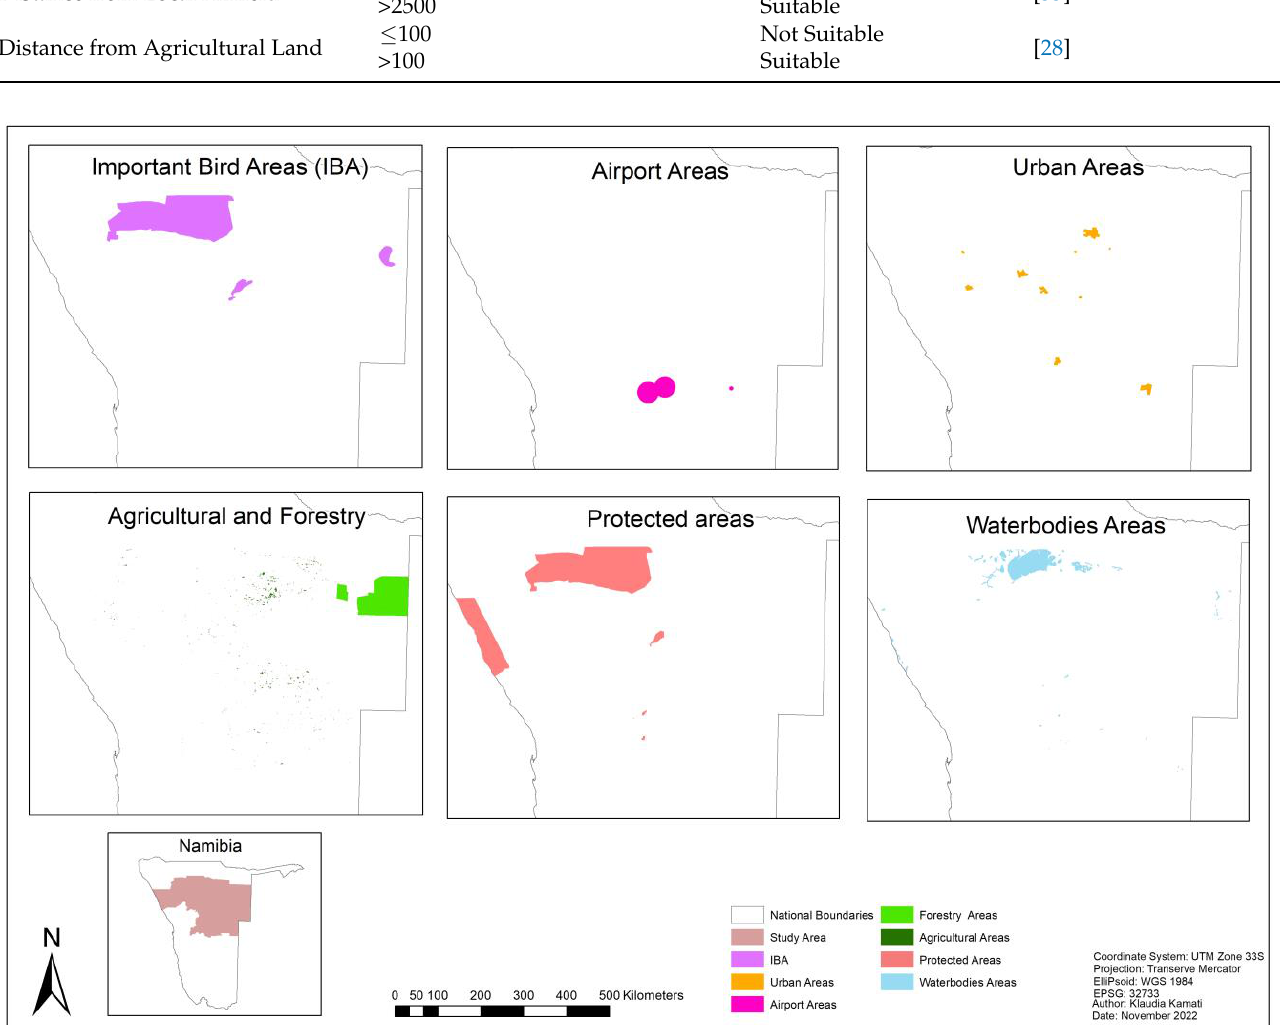
Figure 5. Restricted areas in the study region.